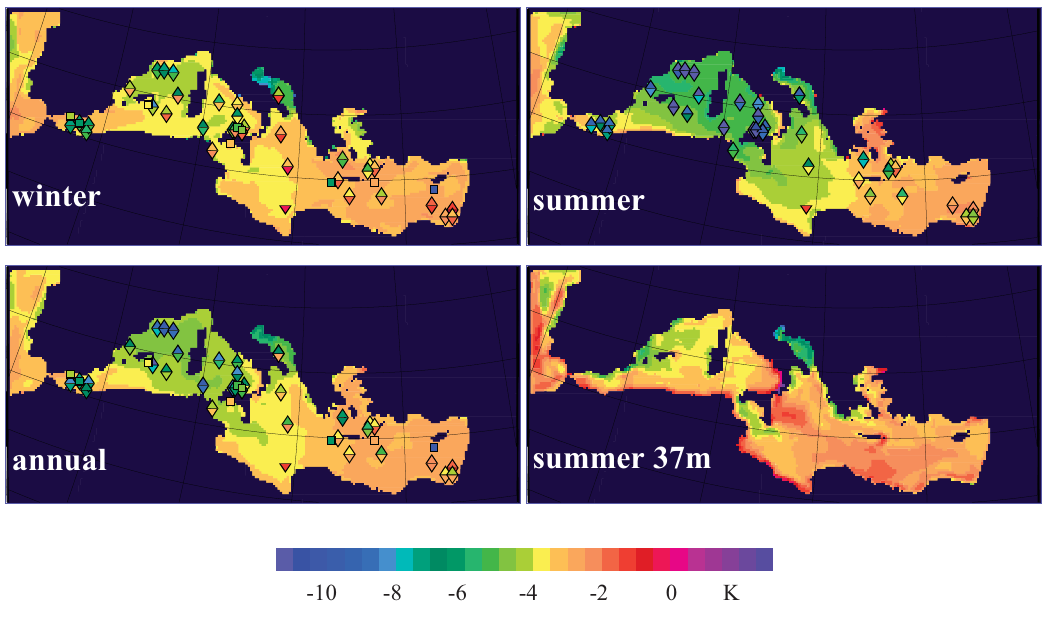
Fig. 9. Simuated temperature anomalies between LGM and CTL in K. Winter (JFM) SST, annual mean SST, summer (JAS) SST, and summer temperature anomalies at 37m depth. Triangles represent anomalies between SST recontructions from assemblages of foraminifera (Hayes et al., 2005) and WOA98 temperatures at 10m depth. Downward triangles represent reconstruction using the ANN method, upward looking triangles using the RAM method. Squares represent differences between alkenone derived temperature estimates for LGM and core top (Lee,